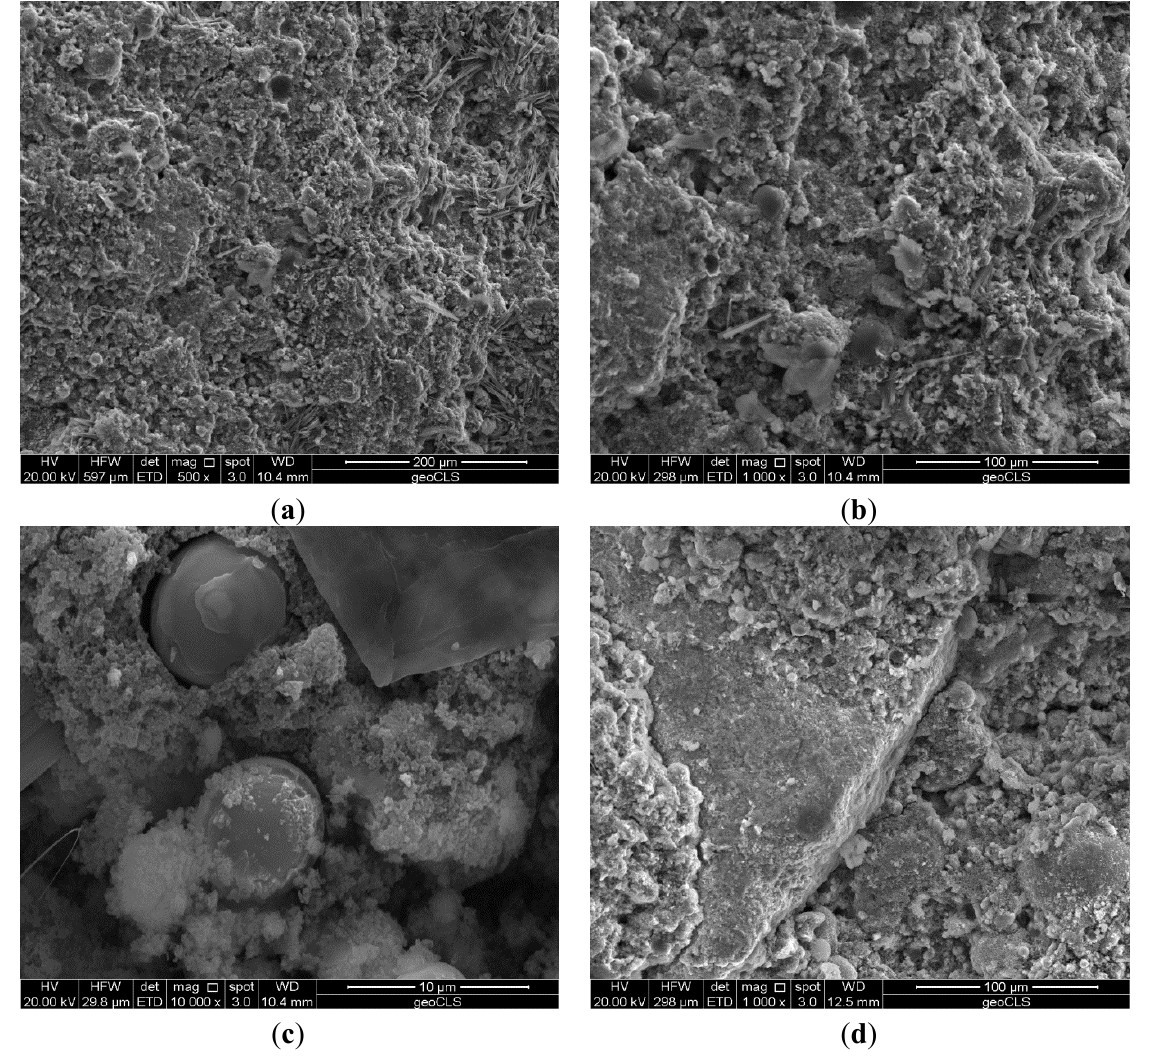
2D Graph after isothermal treatments. c